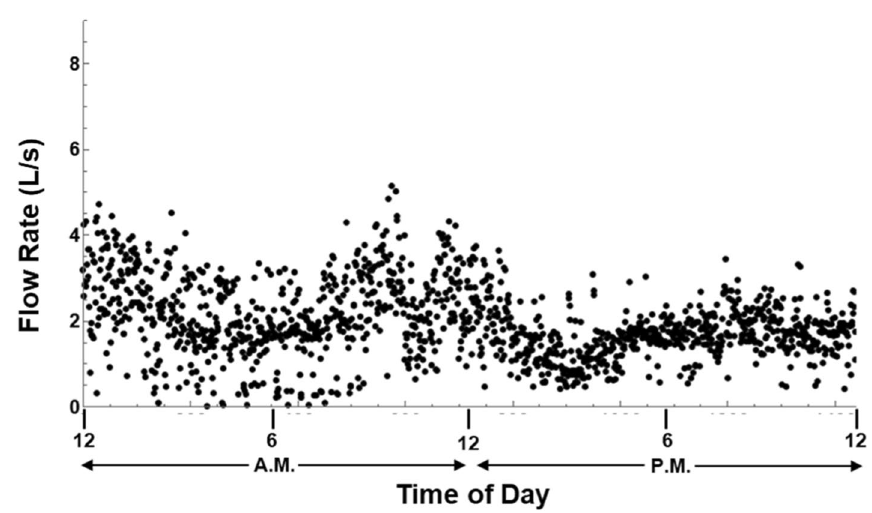
Fig. 14 Saturday average readings for daily